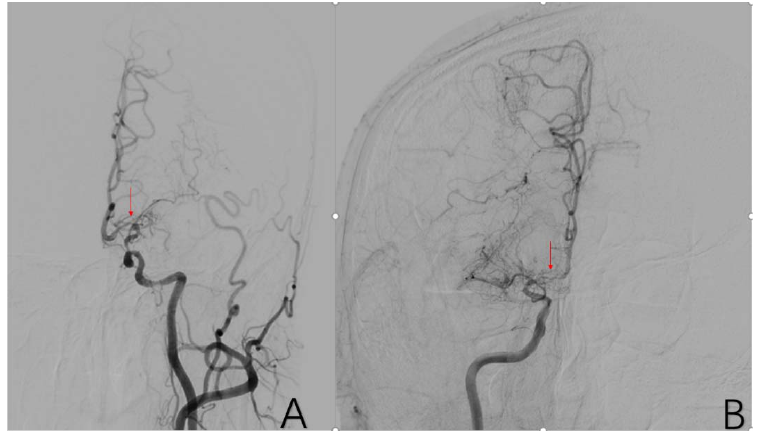
Figure 5. ( A ) is a 48 ‐ year ‐ old male. This is a DSA image of his left common carotid artery. ( B ) is a 43 ‐ year ‐ old male. This is a DSA image of his right internal carotid artery. The red arrows show the location of A1 stenosis.